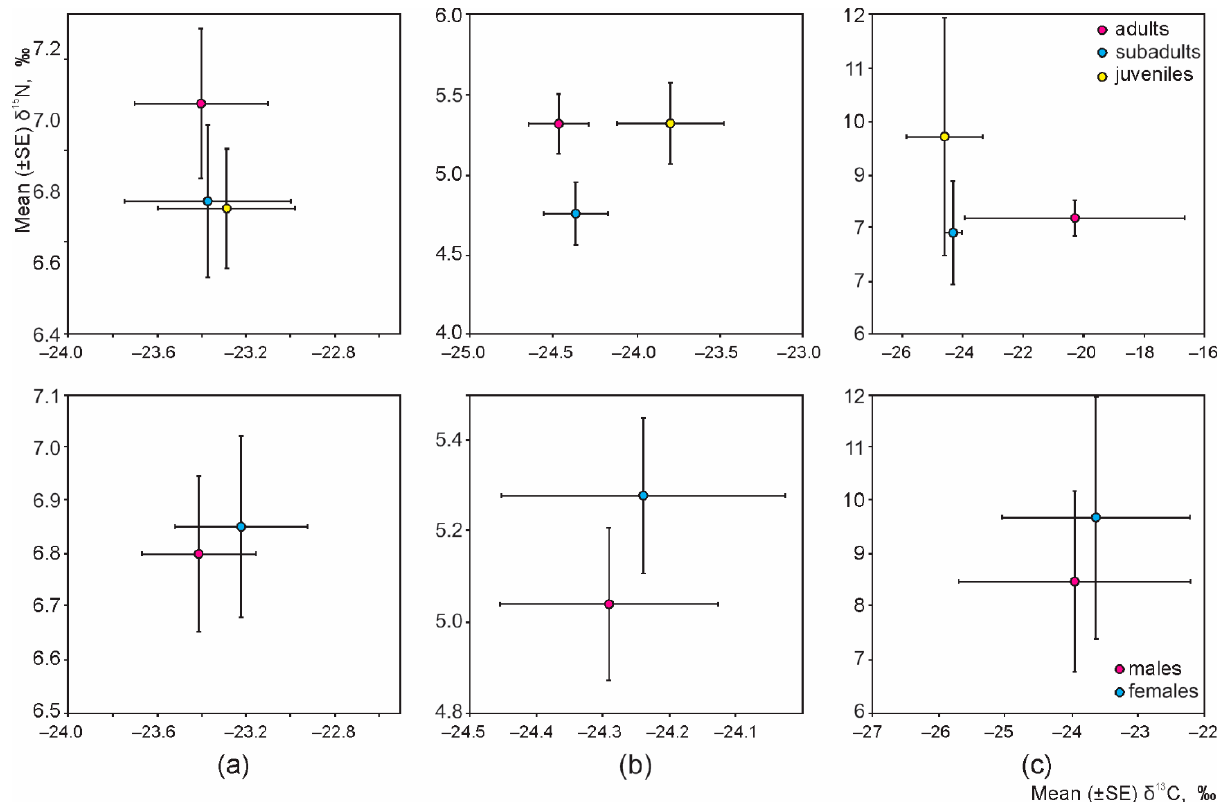
Figure 4. Intraspecific differences of the isotopic niches of A. flavicollis ( a ), A. agrarius ( b ), and M. minutus ( c ), irrespective of habitat.